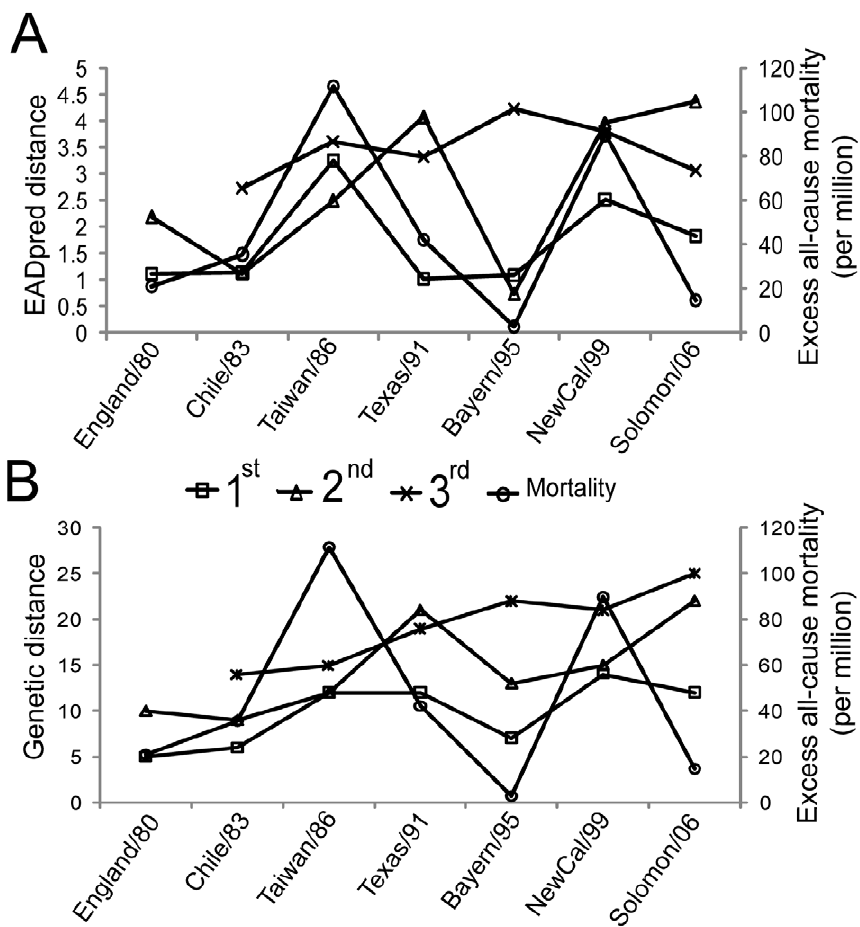
Figure 4. Correlation of predicted antigenic distance (EADpred distance) with excess mortality caused by A(H1N1). (A–B) The correlation between excess all-cause mortality (black) and EADpred (A) /genetic (B) distance to previous single antigenic strains. The symbols O , % , D and 6 indicate the excess all-cause mortality and the antigenic/genetic distances between antigenic strains as challenging strains and the previous first, second, and third antigenic strains, respectively. Information about the antigenic strains sees Table S1.